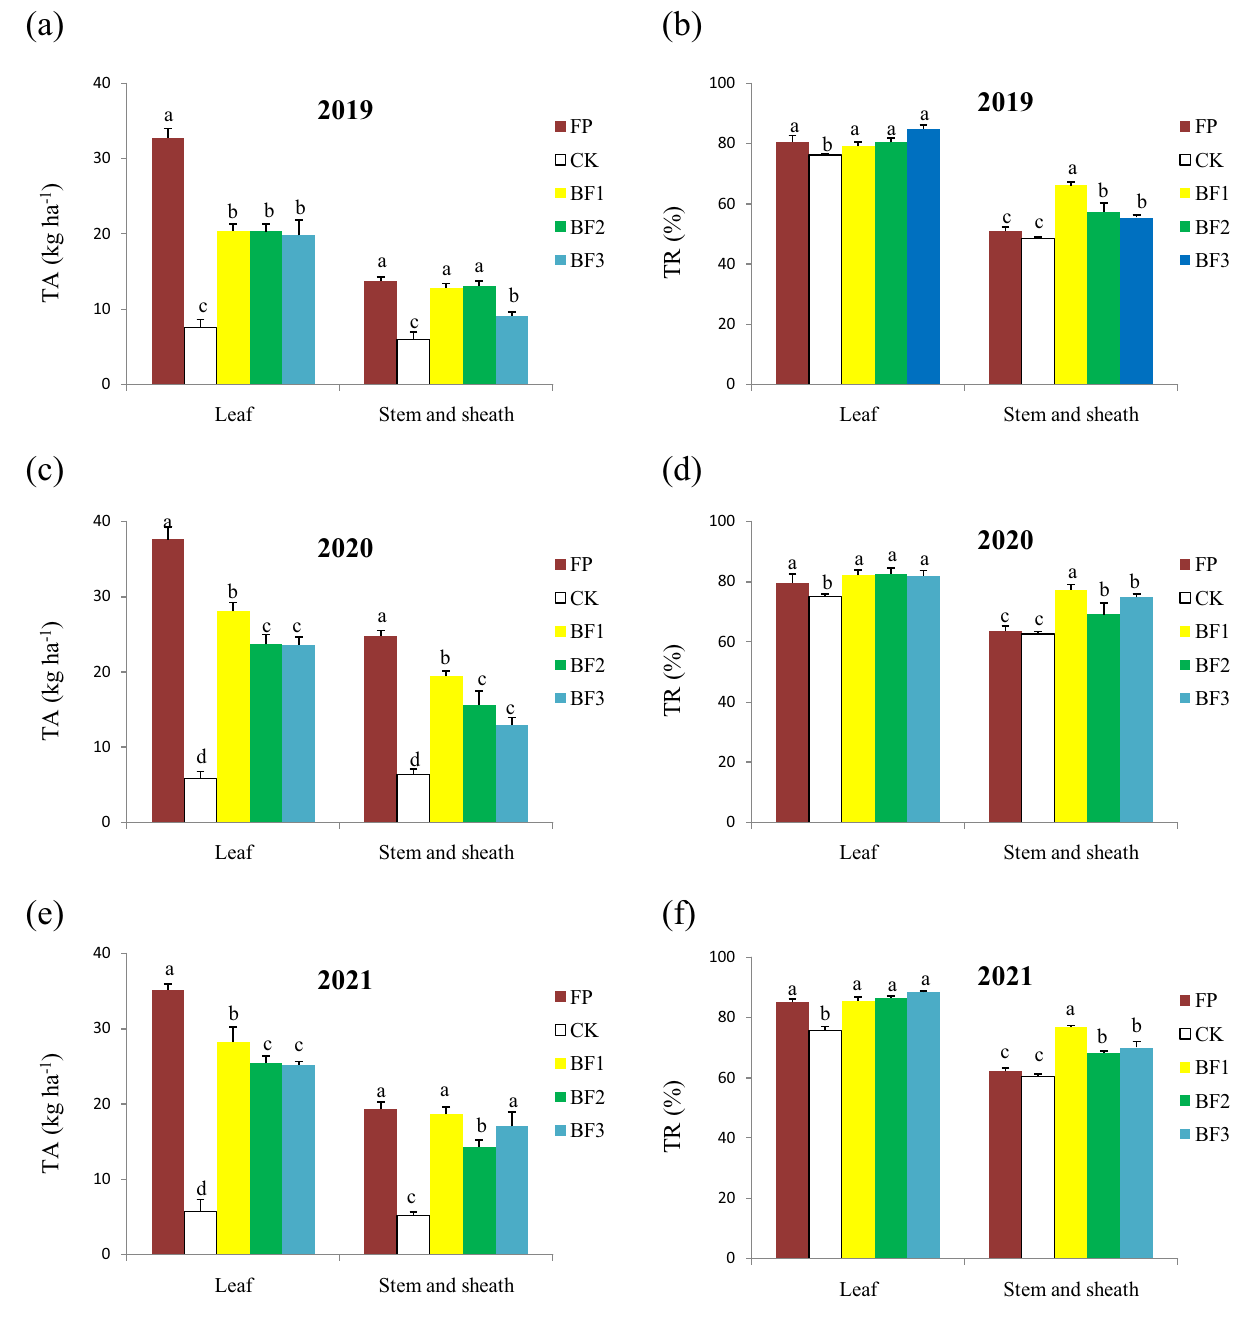
Figure 4. Effects of different balanced fertilization treatments on ( a , c , e ) apparent N translocation and ( b , d , f ) its efficiency in spring wheat from 2019 to 2021. The data are the means and standard errors of three independent measurements. Values within a cluster column with different letters are significant at the P = 0.05 level. TA and TR indicate apparent N translocation and apparent N translocation efficiency,